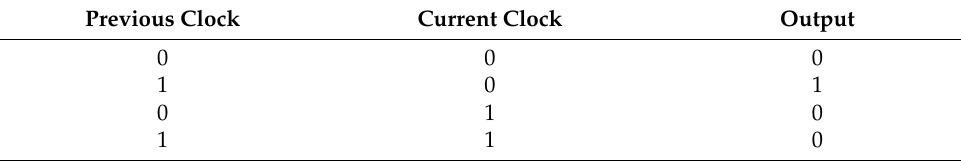
Figure 10. Negative edge detection circuit [16]. Table 4. Negative edge trigger truth table.